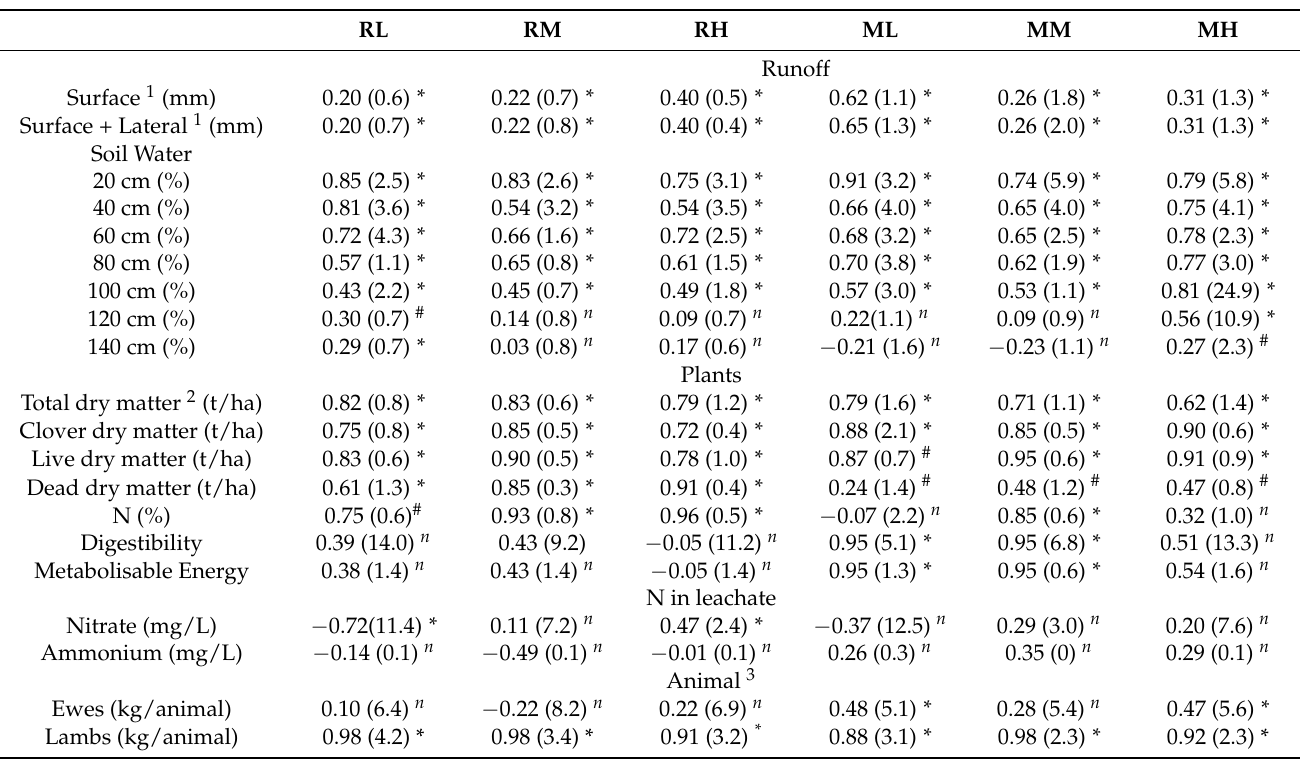
Table 4. Overall ranked correlation coefficients for the different grazing systems for 1999–2001. The data for lambs are for the period 1997–2000. (Numbers in brackets are the